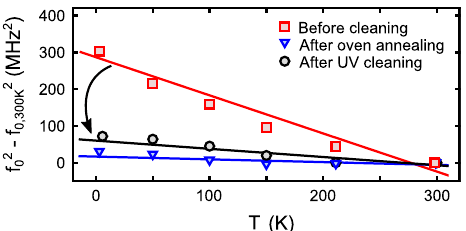
Fig. 4 Temperature dependence of the mechanical resonance frequency (fundamental mode) averaged for the h-BN drums before cleaning, after oven annealing, and after UV ozone cleaning. By cooling the drums from 300 K down to 3 K, the material is tensioned resulting in higher frequencies. Despite the expected negative in- plane thermal coef fi cient of h-BN, no compression is observed even after cleaning, hence suggesting that other tensioning mechanisms are